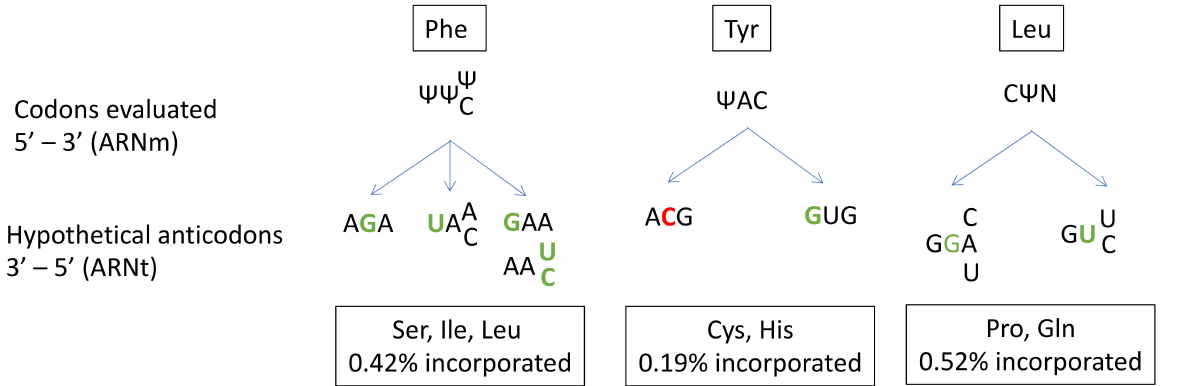
Figure 3. Prediction of anticodon substitution in front of codons with pseudo-uridine ( Ψ ), based on the amino acid mis- incorporated in the study of Eyler et.al. (2019). Nucleotides in green indicate a mismatch in front of Ψ . Nucleotides in red indicate a mismatch next to Ψ . N: A, U, C or G base. Possibilities of codon-anticodon pairings with more than one mismatch are not